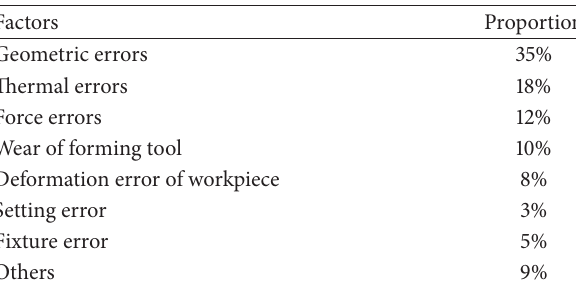
Table 1: The proportion of internal error